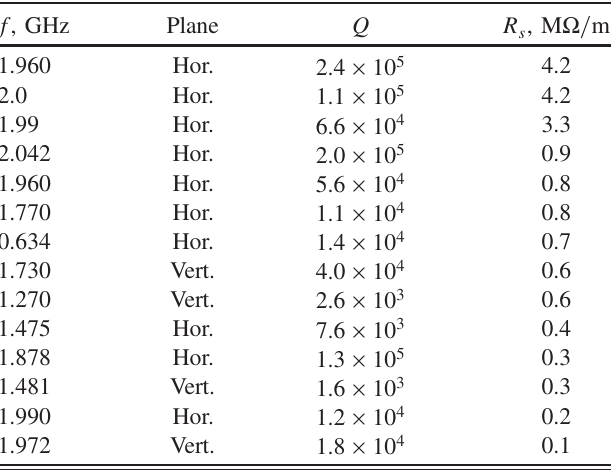
TABLE V. RFD HOMs with the largest transverse shunt impedance. Simulation data from HL-LHC impedance model as of Oct.